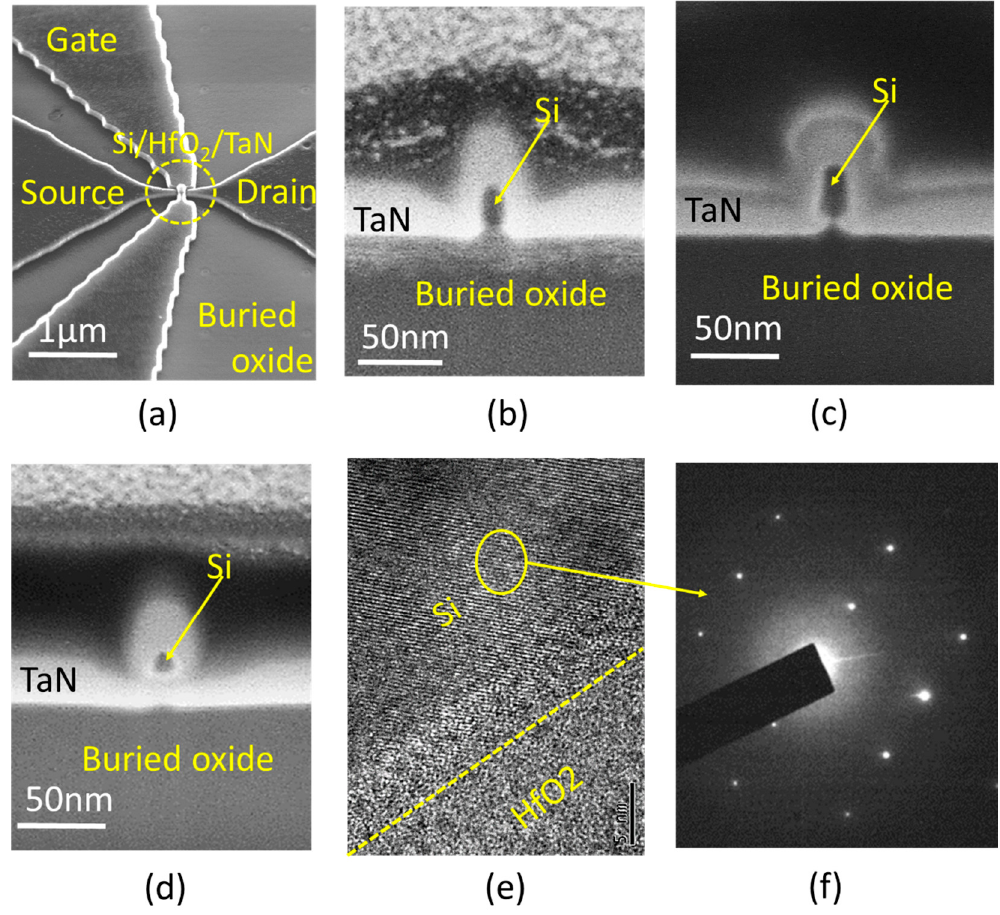
Figure 4. ( a ) A tilted SEM image of a multi-wire GAA Si NW FET. The configurations of ( b ) tri-gate, ( c ) Ω -gate, and ( d ) GAA Si FET with different soaking times in the channel fabrication step. ( e ) A HRTEM image of single-grain Si and HfO 2 dialectic layer. ( f ) A selected area diffraction pattern (SADP) from Si.